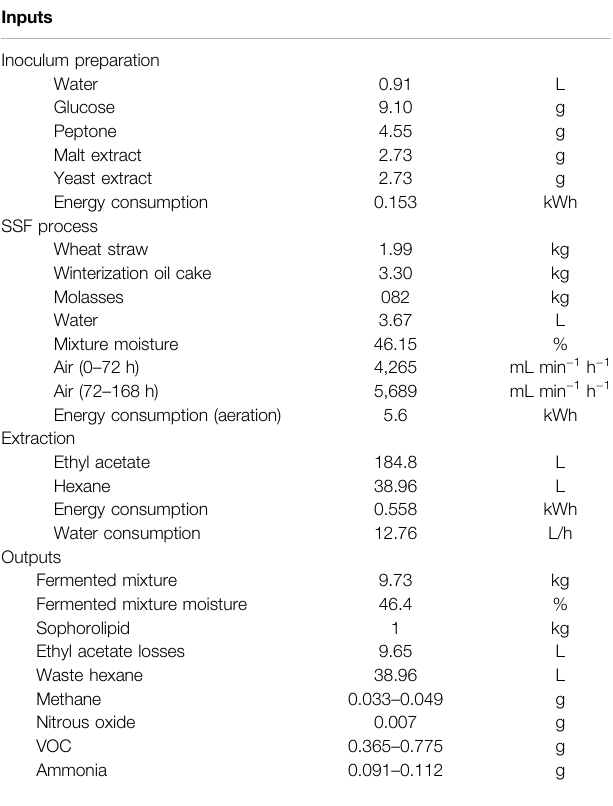
TABLE 2 | Inputs and Outputs to a R22 batch process to produce sophorolipids through Solid State Fermentation. All values referred to the production of 1 kg of